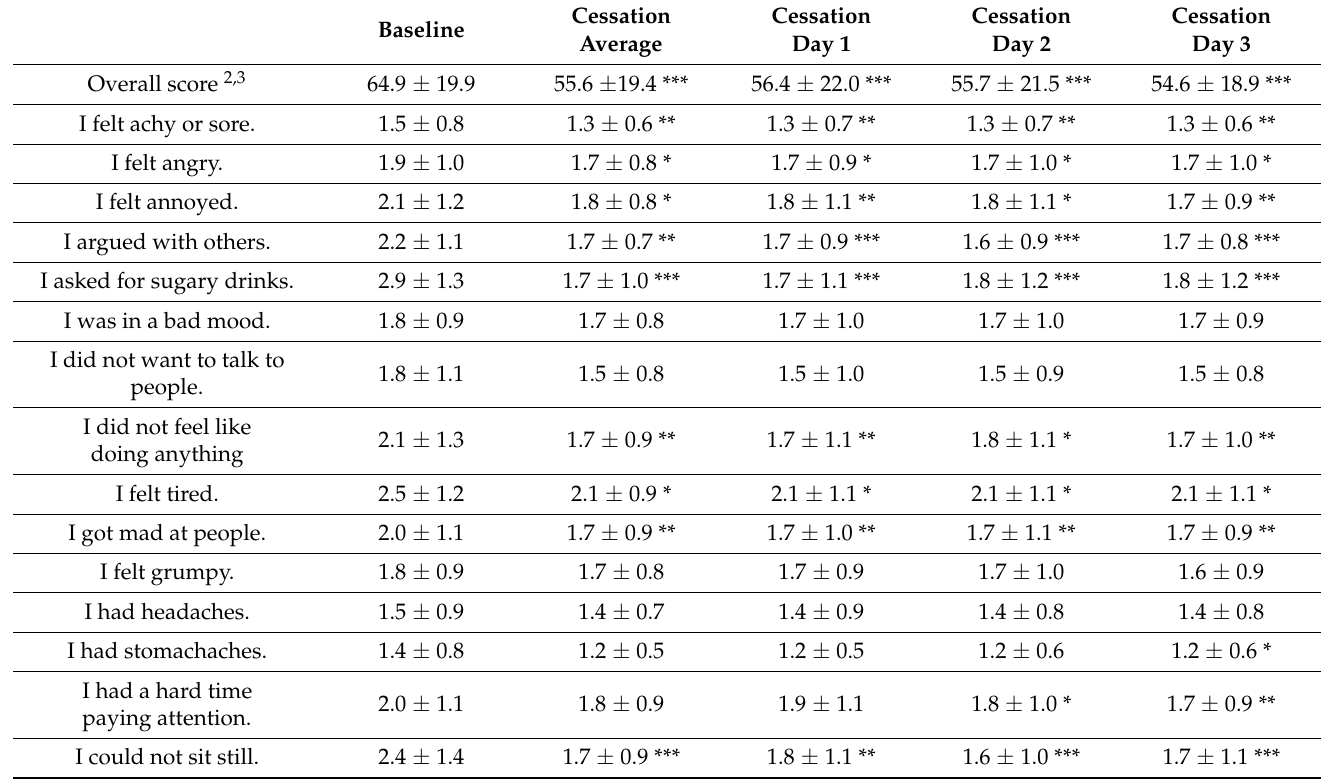
Table 3. Physical and emotional feelings reported on the daily feelings questionnaire at baseline and during three days of sugary drink cessation; n = 149 1